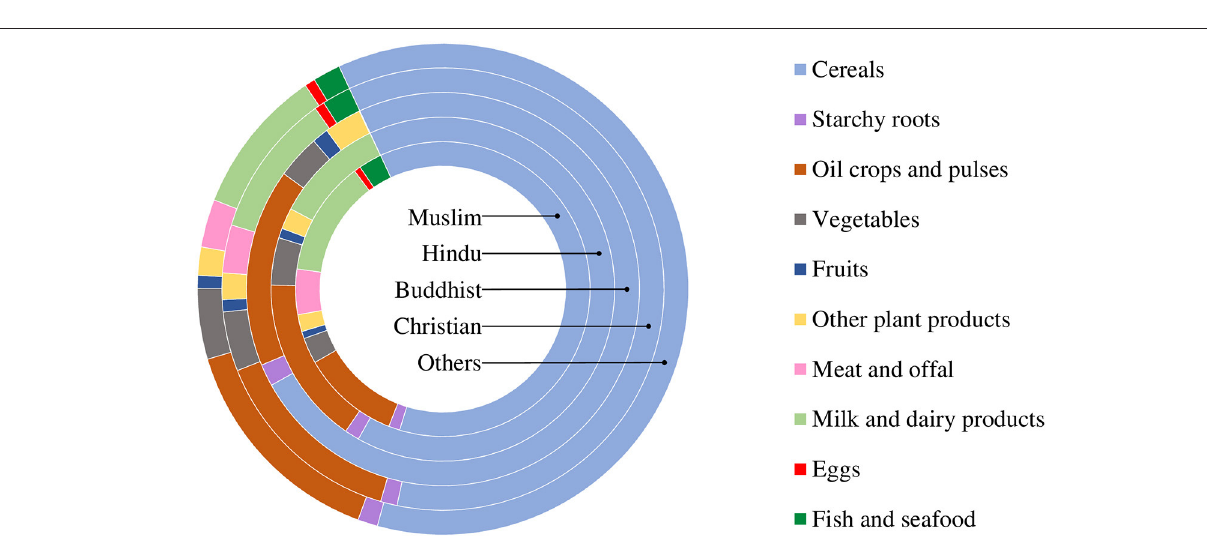
FIGURE 4 | N consumed from food by religious communities in the